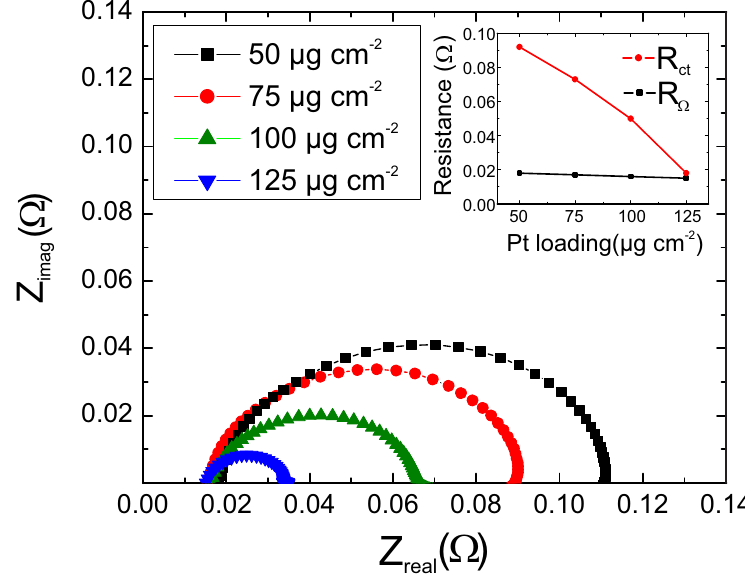
Figure 5. Electrochemical impedance spectroscopy curves of PEM fuel cells with various Pt loadings at the cathode at a cell voltage of 0.8 V. The inset shows the charge-transfer resistance and ohmic resistance as functions of Pt